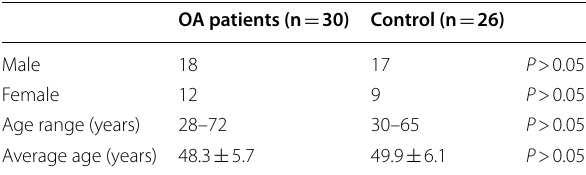
Table 1 Demographic data of the OA patients and the control